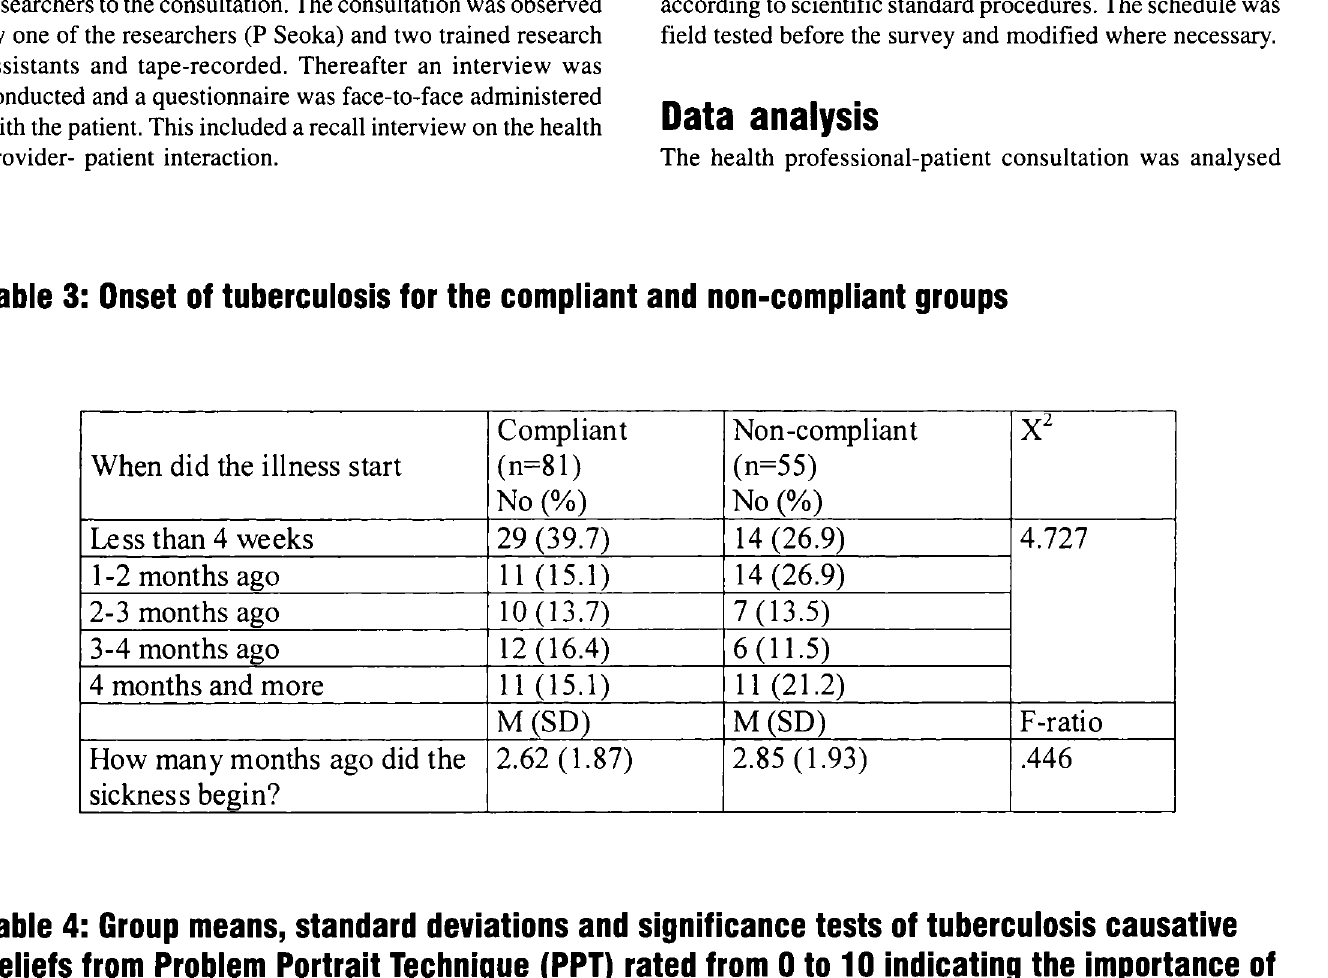
Table 4: Group means, standard deviations and significance tests of tuberculosis causative beliefs from Problem Portrait Technique (PPT) rated from 0 to 10 indicating the importance of the behaviour (10 being most important) as well as frequency of agreed responses (in percent) for the compliant and non-compliant